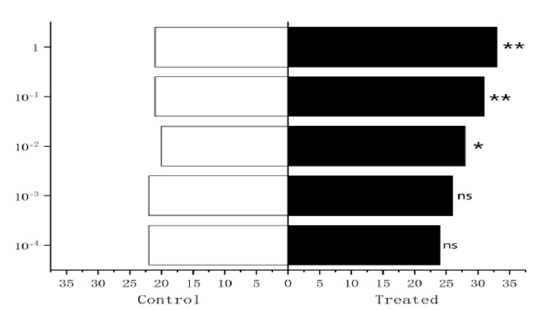
Figure 31. Behavioral responses to 1-octen-3-ol in female W. magnifica .